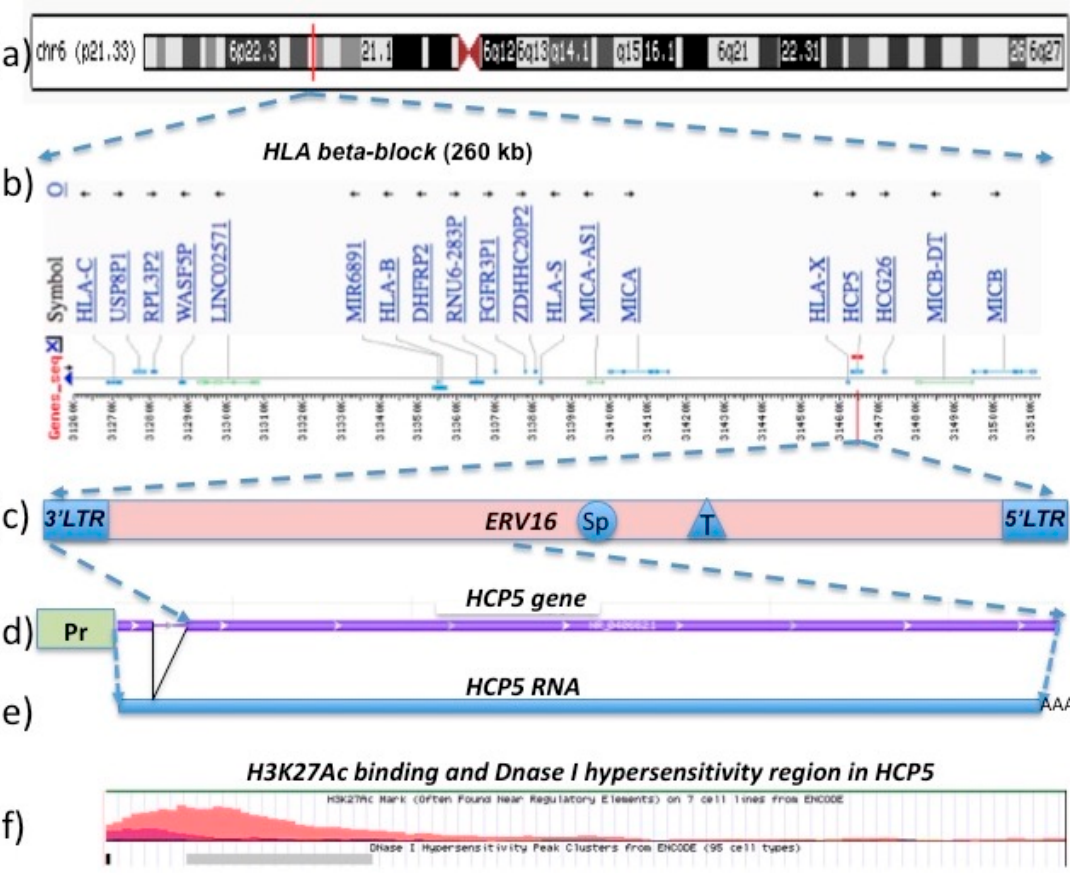
Figure 1. Location of the HCP5 gene ( d ) within the ERV16 element ( c ) and the human leukocyte antigen (HLA) class I region of the beta-block ( b ) on chromosome 6 at 6p21.33 ( a ). The HLA class I promoter region (the green rectangle labeled as Pr) for the 2630 bp HCP5 gene ( d ) initiates transcription of the 2547 bp lnc HCP5 RNA ( e ). The 91 bp intron in the HCP5 gene is represented by the thin grey line between the violet rectangular lines ( d ). The AluSp , T HE1B, and LTR162B insertions within the 6173 bp ERV16 sequence [30] ( c ) are indicated by the labeled circle, triangle, and rectangles, respectively (see Table 1 for more details). The H3K27Ac binding (orange curve) and Dnase I hypersensitivity region (grey horizontal rectangle) associated with the HCP5 gene sequence ( d ) and sourced from the University of California, Santa Cruz (UCSC) genomic browser (Table S1) are shown on line ( f ).